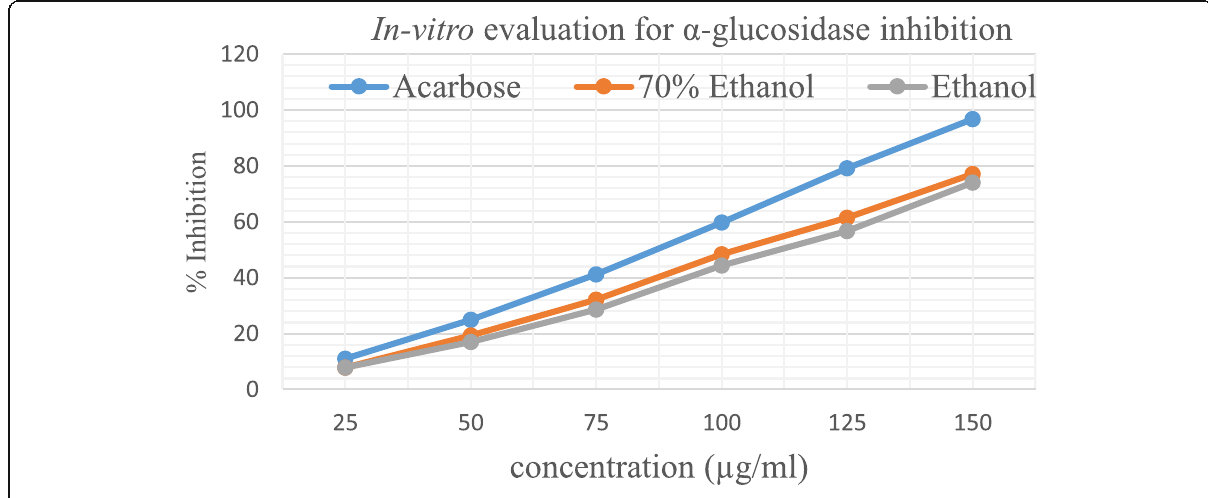
Fig. 6 In vitro evaluation for α -glucosidase enzyme hyperglycemia in type II diabetes through α -glucosidase enzyme inhibition. The results of the present study indi- cate the possibility of an economical source for the pro- duction of potential supplement(s) of the antioxidant and α -glucosidase inhibitor from the natural source.